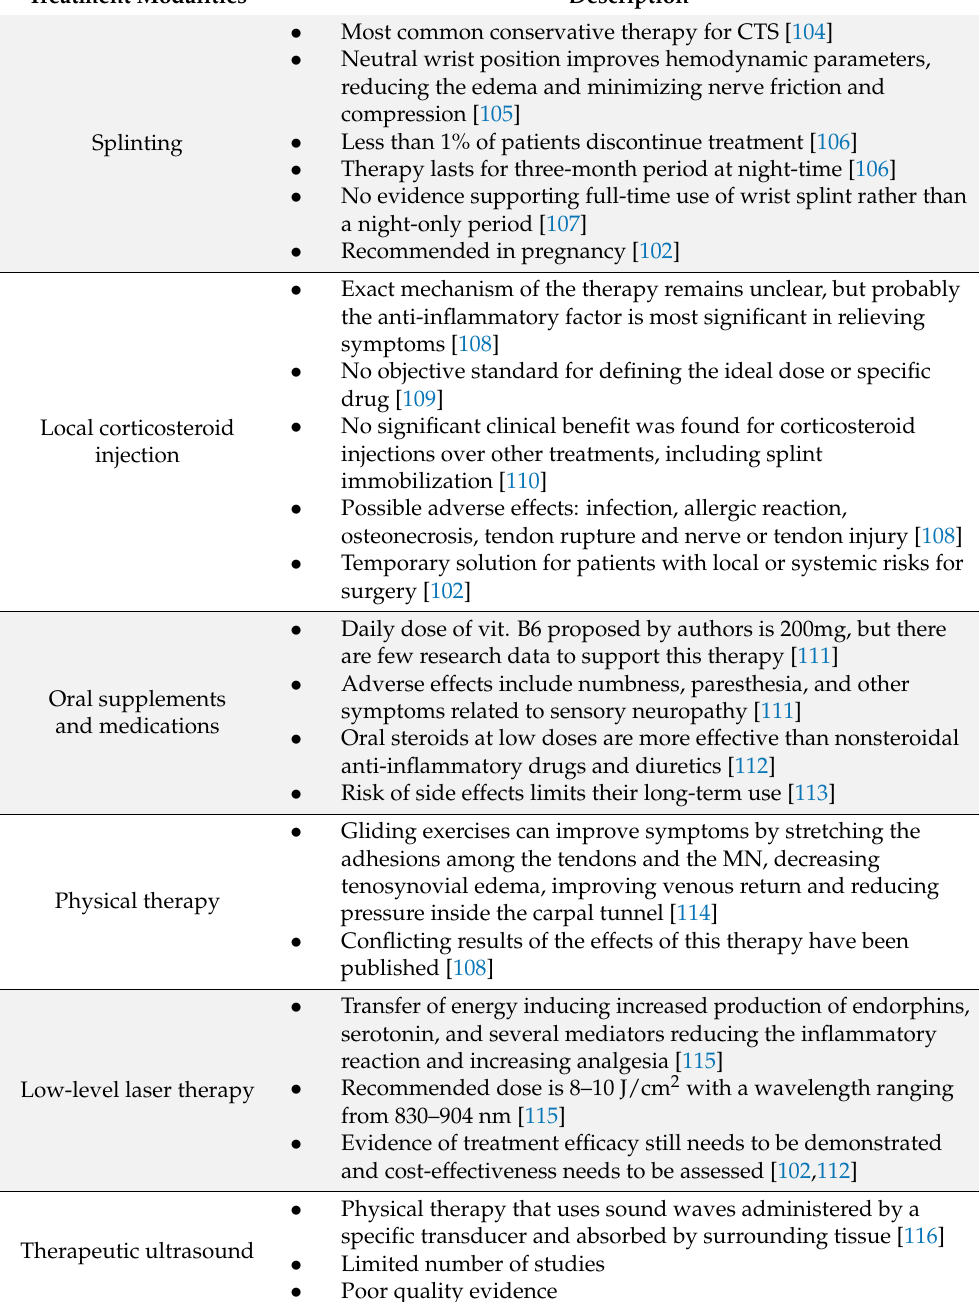
Table 4. Conservative treatment modalities for